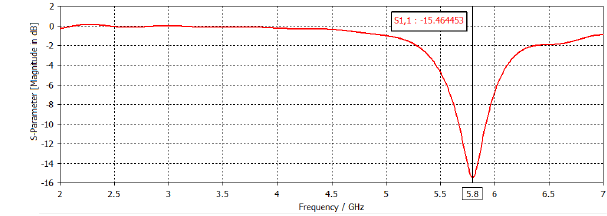
Figure 9. Return loss for Arlon Di 522.